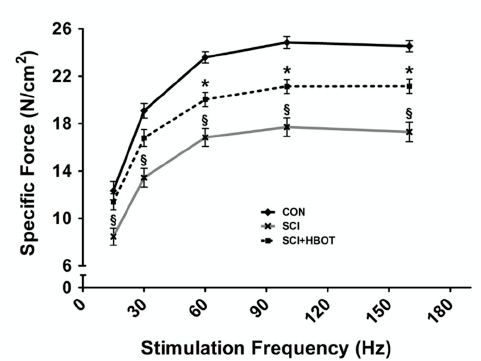
Figure 1. Diaphragm muscle force–frequency response. Values are mean ± SEM. § Significantly different versus all groups ( p < 0.05). * Significantly different versus CON group ( p < 0.05). CON—non-injured, room air exposure; SCI—lateral-cervical spinal cord contusion, room air exposure; and SCI + HBOT— lateral-cervical spinal cord contusion, HBO therapy.